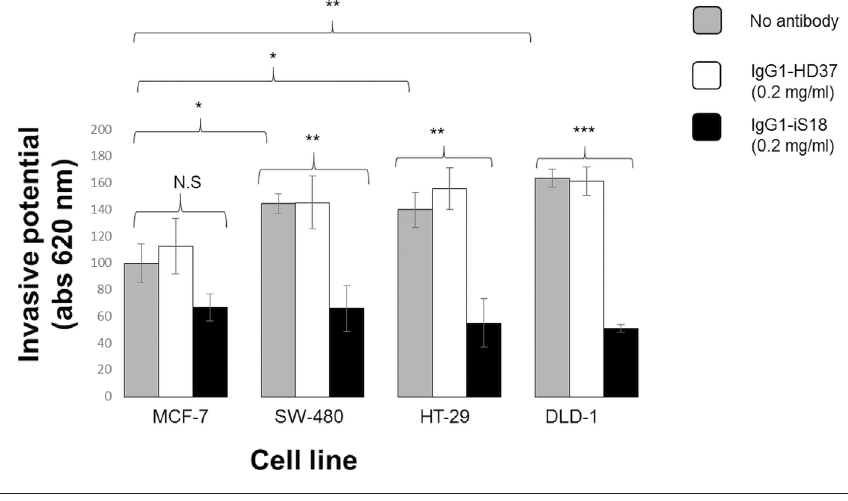
Figure 6. Invasion of ECM-like Matrigel™ by tumorigenic cell lines. Each cell line’s